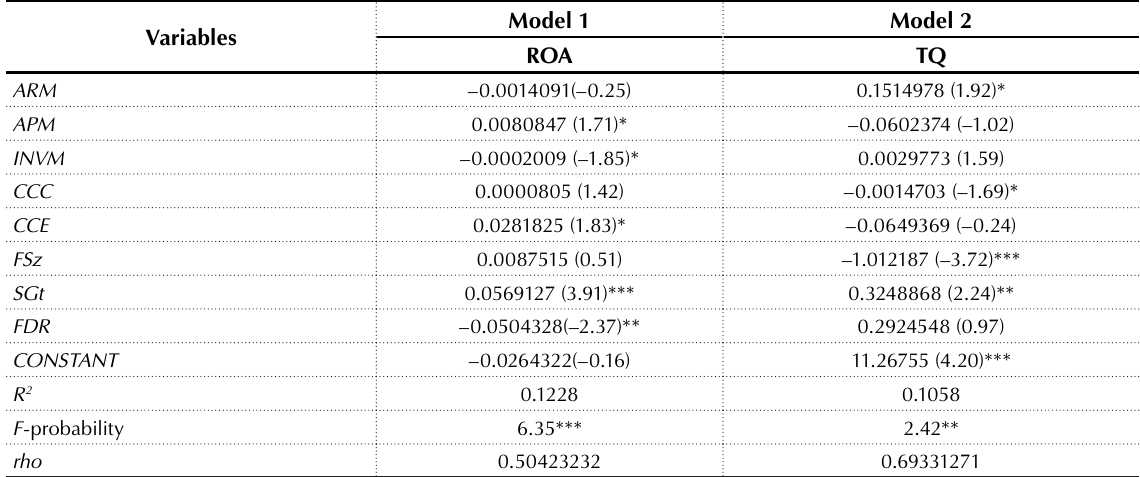
Table 6. Regression results of WCM and firm